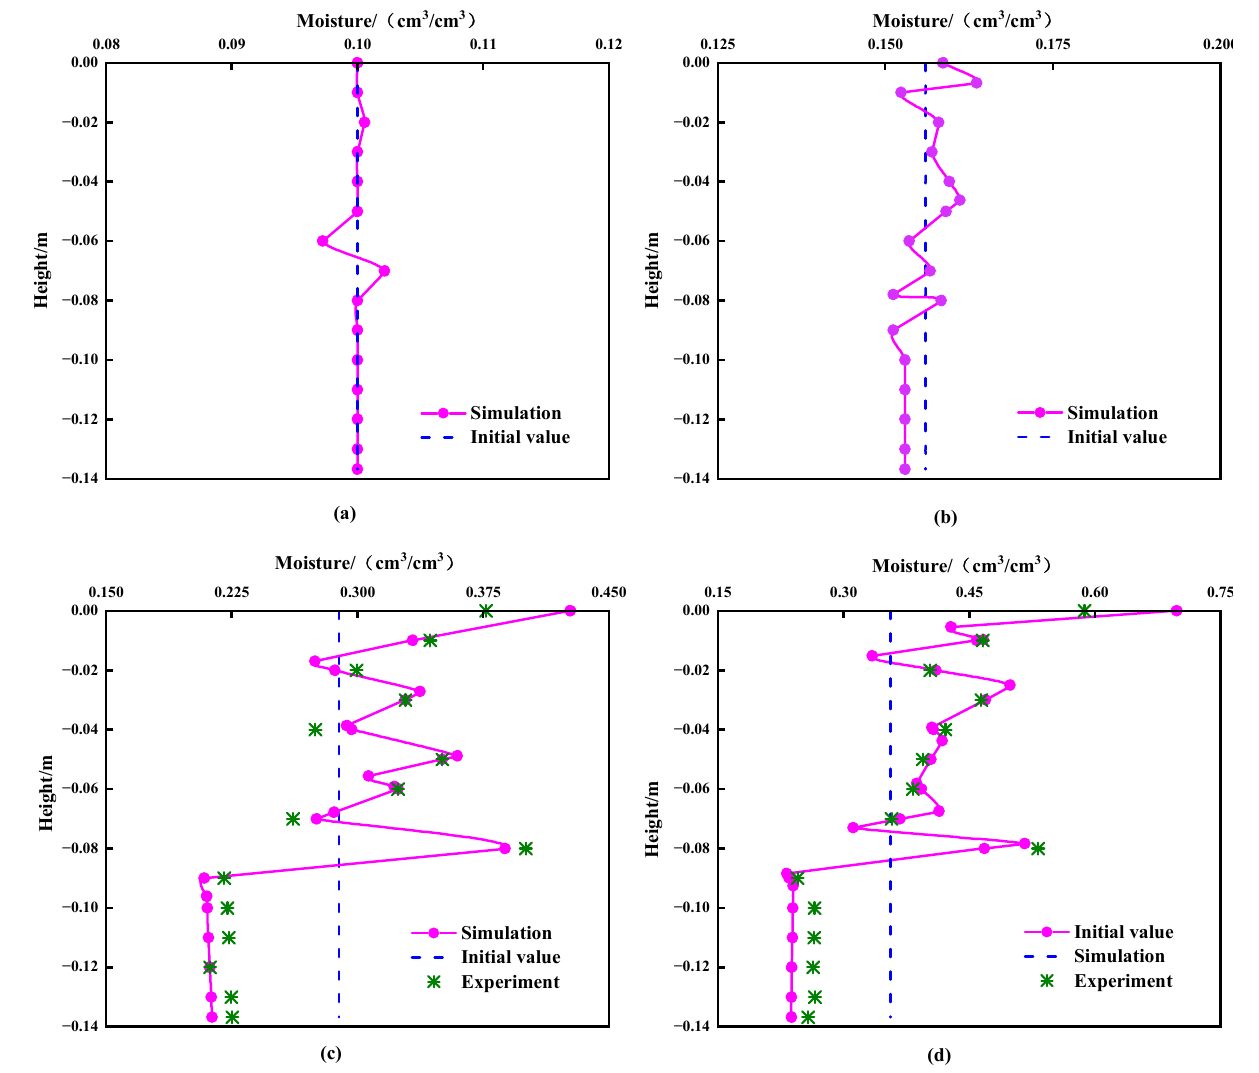
Figure 9. Comparison of simulation and experiment. ( a ) Field of temperature; ( b ) field of moisture. ( a ) S = 0.2; ( b ) S = 0.35; ( c ) S = 0.65; ( d ) S = 0.8. ( a ) S = 0.2; ( b ) S = 0.35; ( c ) S = 0.65; ( d ) S =